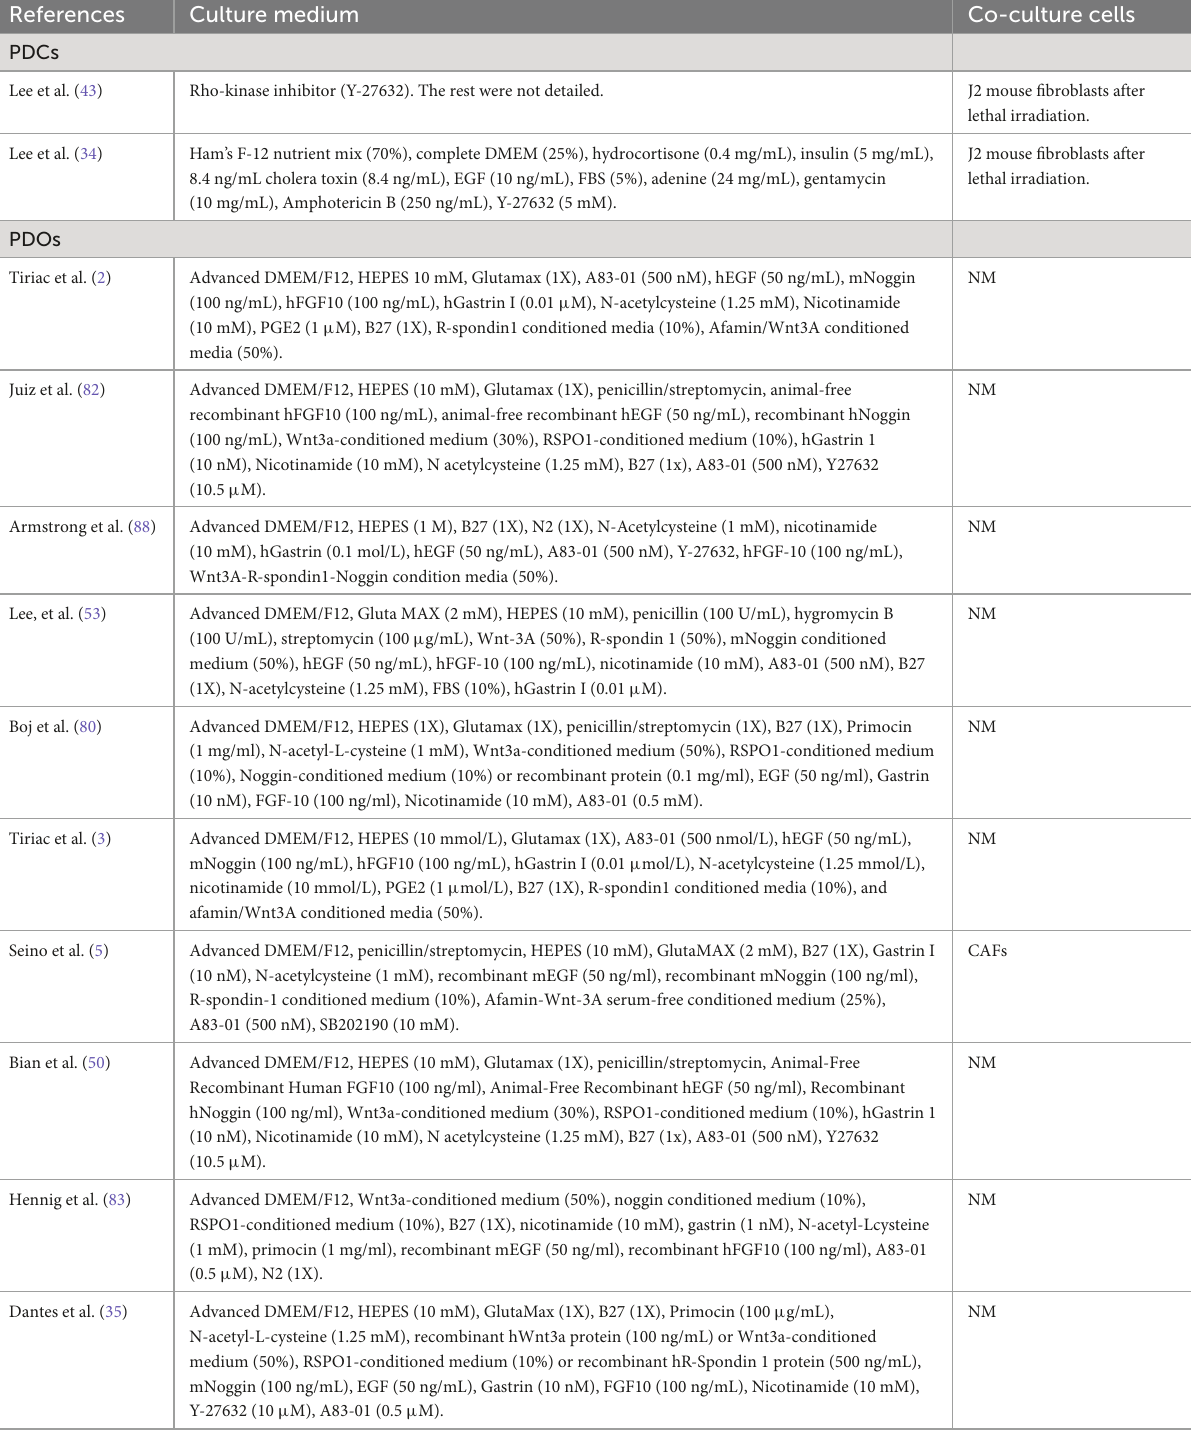
TABLE 1 Culture medium and co-culture cells of patient-derived cells (PDCs) and patient-derived organoids (PDOs) derived from pancreatic ductal adenocarcinoma (PDAC) specimens obtained by endoscopic ultrasound-guided tissue acquisition